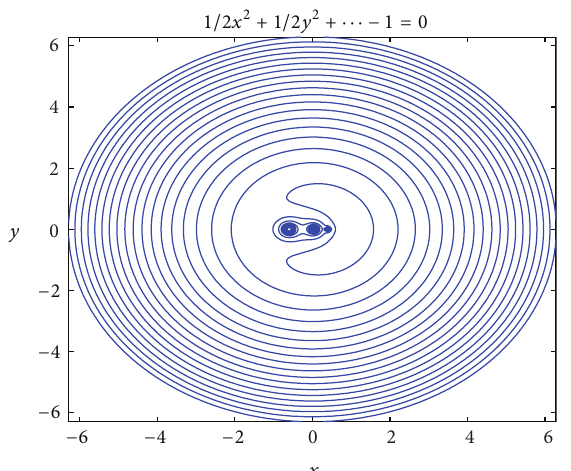
Figure 18: Curve of zero velocity (Xi Bootis-1) 𝑞 1 = 0.9988 , 𝑞 2 = = 0 , 𝐴 = 0 . 0.9988 , and 𝐴 1 2